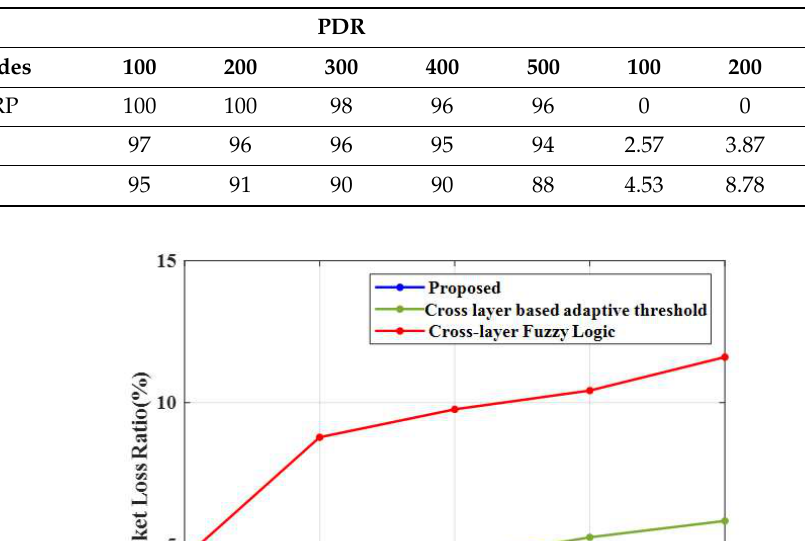
Table 6. Comparison of PDR and PLR.